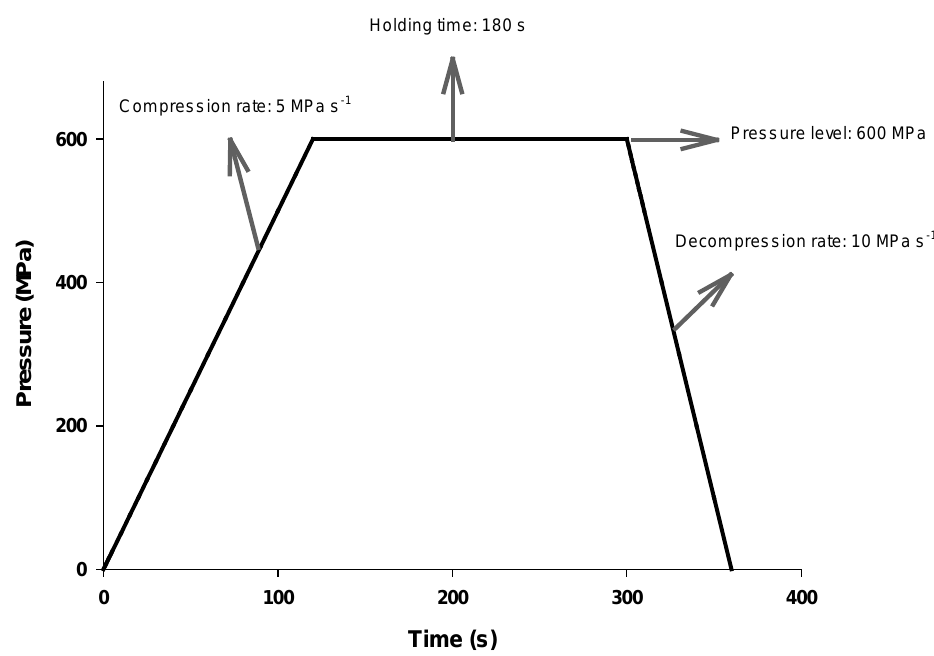
Figure 1. Classical or single-pulsed high hydrostatic pressure (HHP) treatment consisting of compression rate (5 MPa·s −1 ), holding time (180 s) at a constant pressure level (600 MPa), and decompression rate (10 MPa·s −1 ). Note that total duration of the treatment is 360 s (6 min).